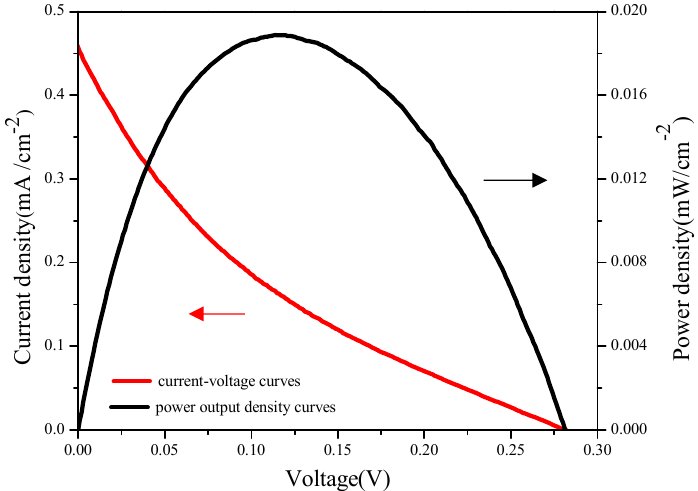
Figure 11. Electricity generation of PFC/PS system for the eye-drops sample treatment. Experimental conditions: [PS] = 3 mM, pH = 3, and electrolyte: 0.1 M Na 2 SO 4 .